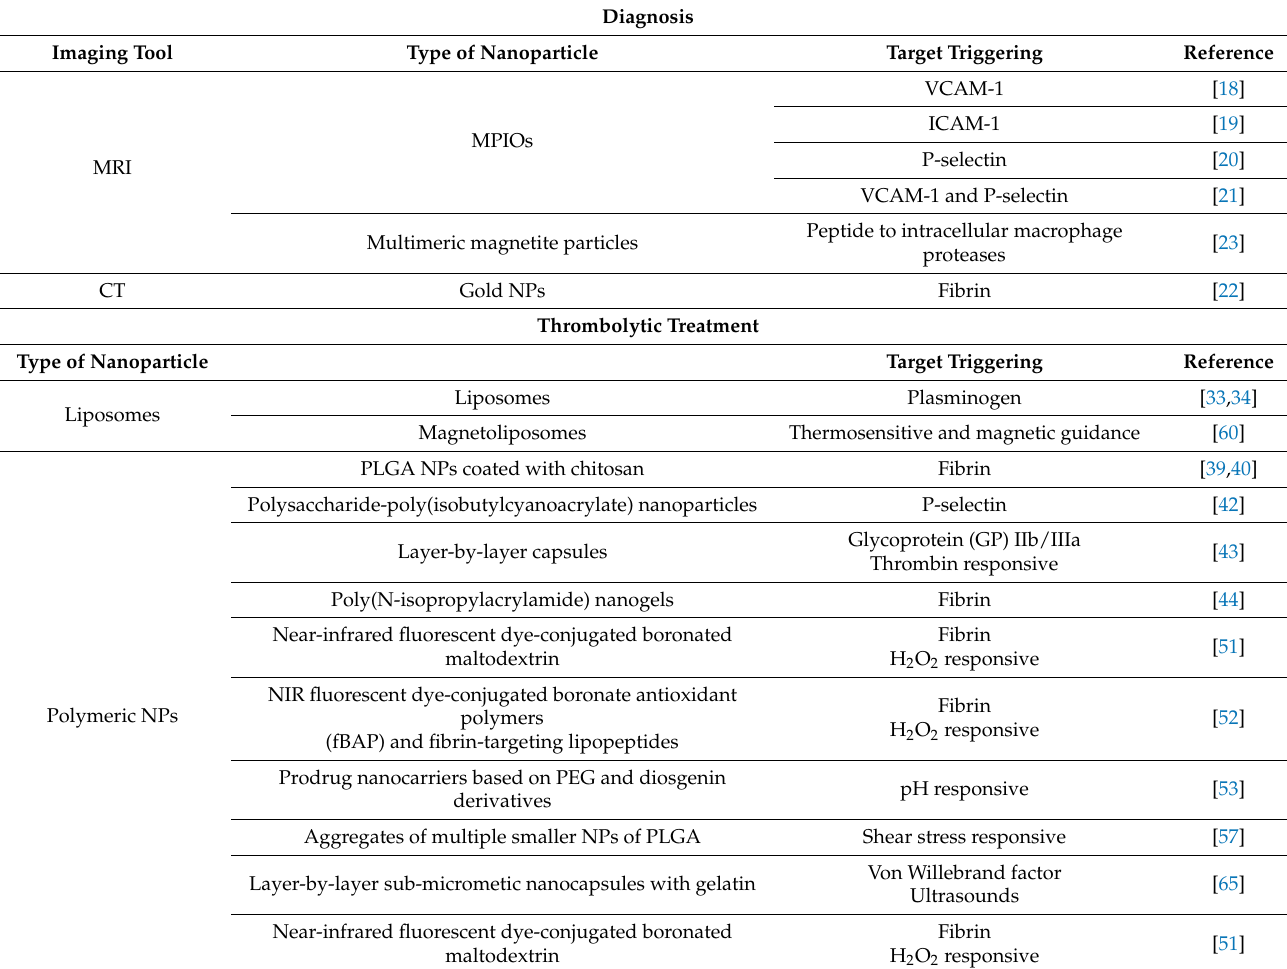
Table 1. Summary of the most relevant nanosystems developed in the ischemia